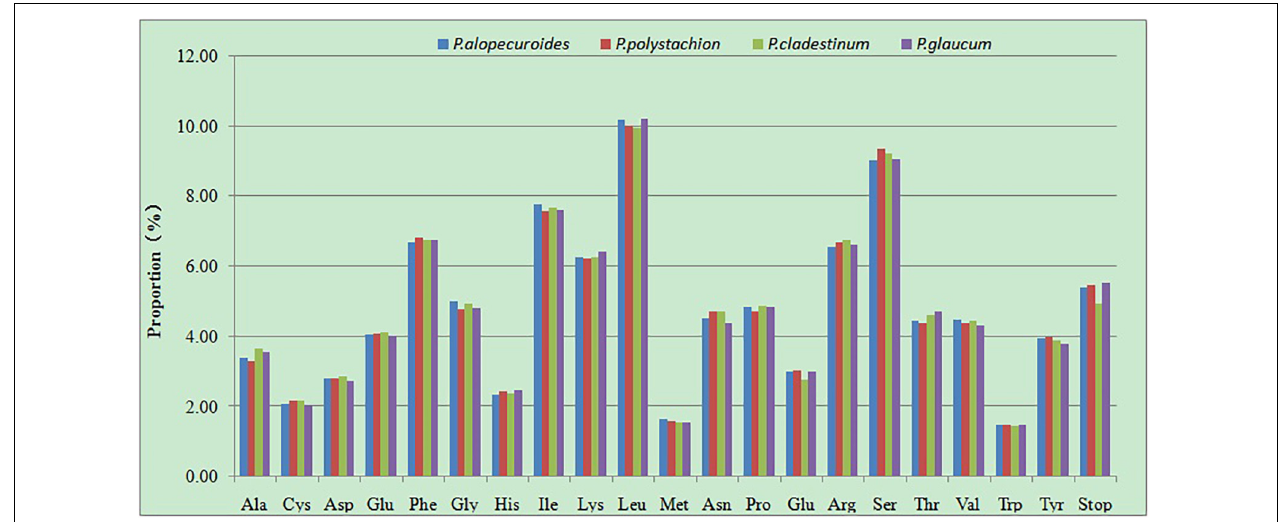
FIGURE 6 | Amino acid proportion in four Pennisetum species protein-coding